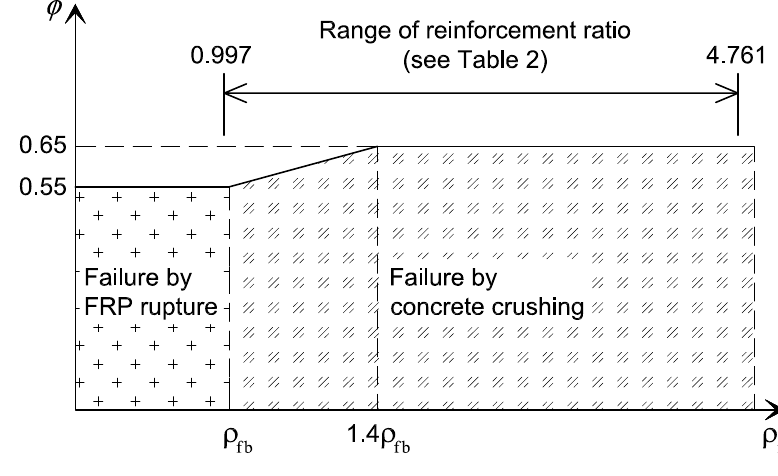
Figure 2. The strength reduction factor as a function of the reinforcement ratio (adapted from ACI 440.1R-06